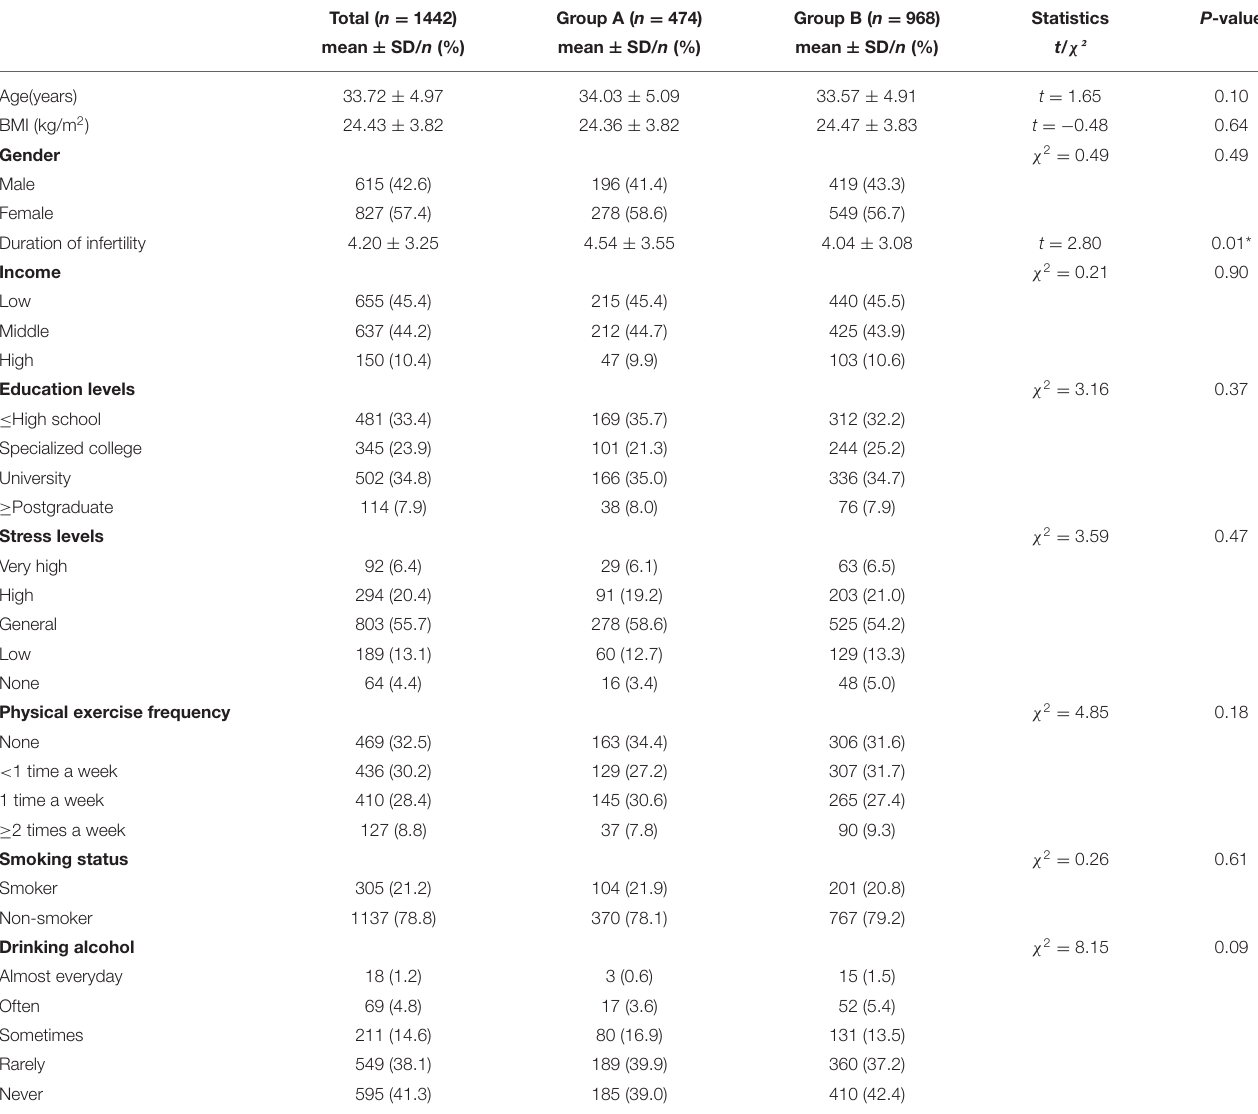
TABLE 1 | Demographic characteristics of the subject